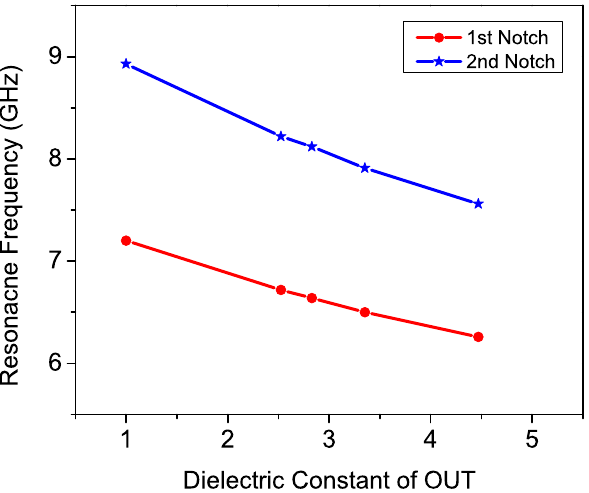
Figure 9. Dielectric constant of OUT versus the resonance frequency of the sensor due to interaction with the